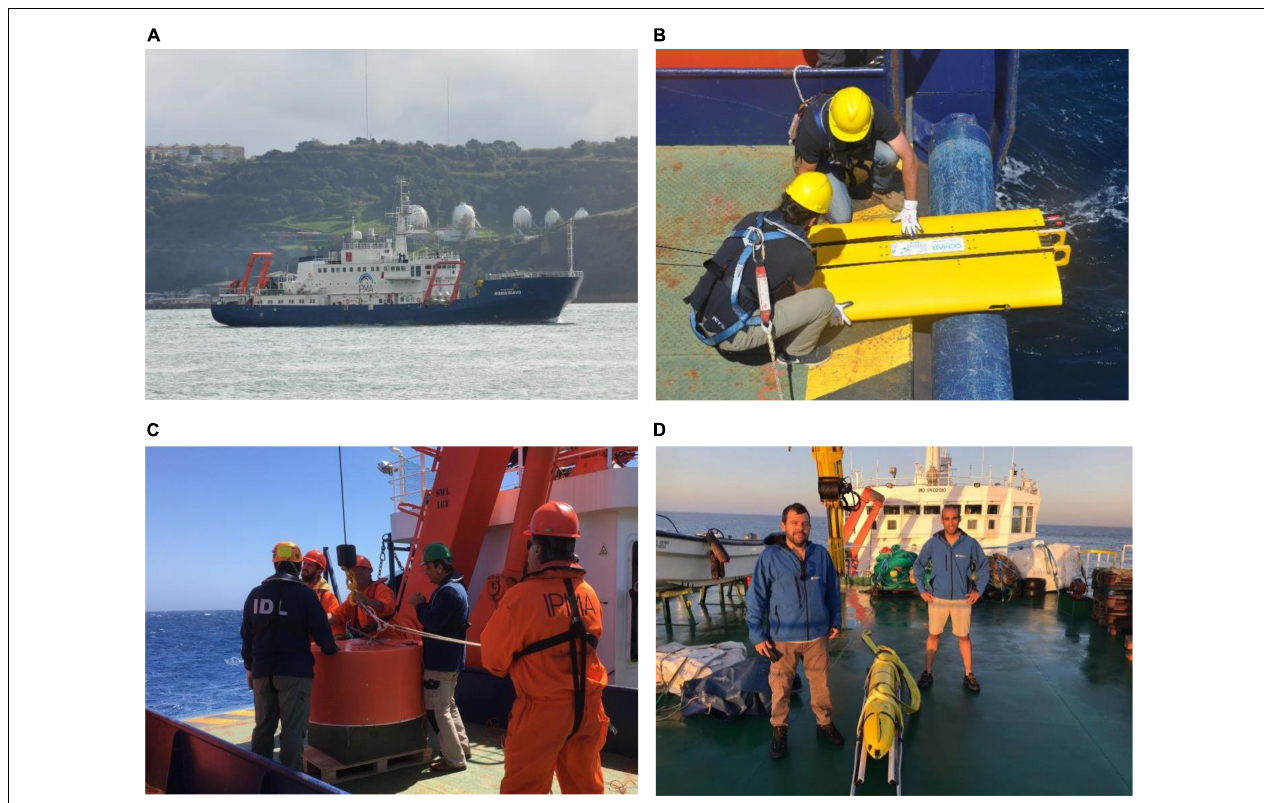
FIGURE 2 | Deployments of oceanographic equipment in the scope of the EMSO-PT pilot oceanographic campaign on-board IPMA’s RV Mário Ruivo. (A) RV Mário Ruivo owned by IPMA. (B) Water column profiler being deployed by the Centre of Marine Sciences and University of Algarve team. (C) Ocean-bottom